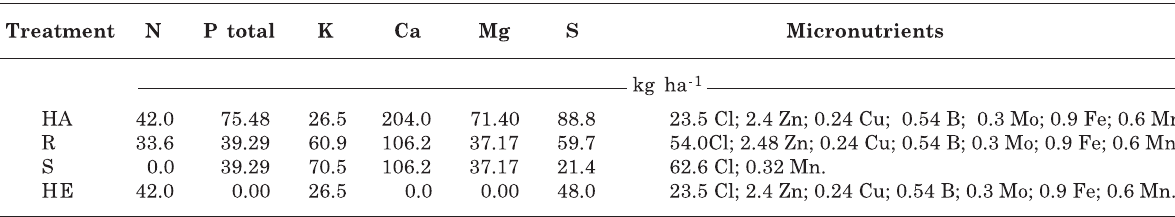
Table 2. Total nutrient amount applied in recovery treatments of low-productivity pasture. Note: treatment C was not